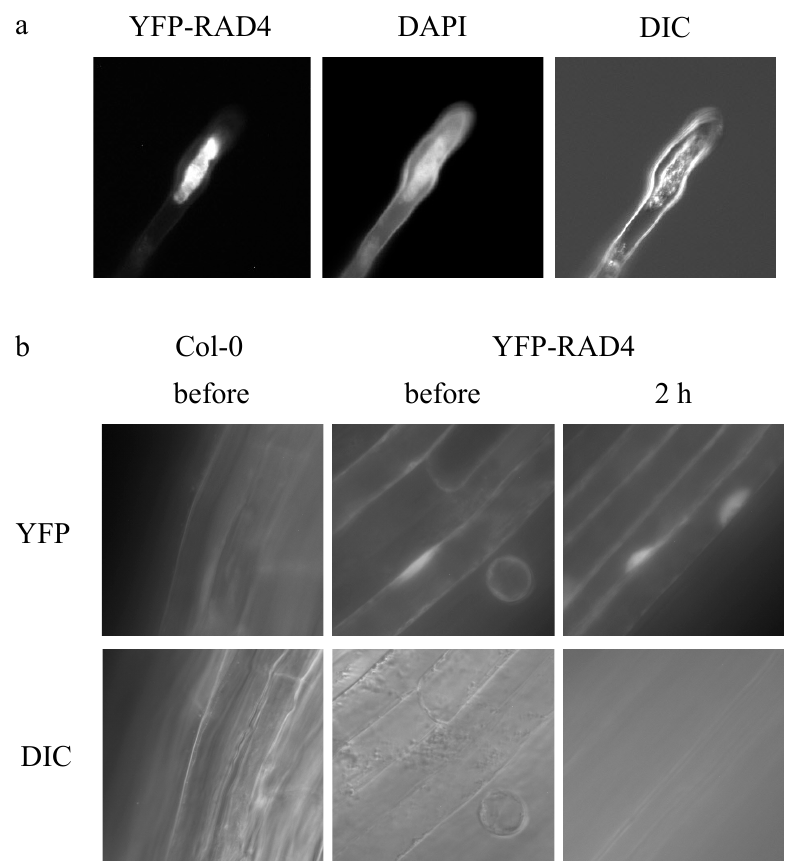
Figure 2. YFP-RAD4 exhibits nuclear localization. ( a ) Root hair cells in three-day-old 35S:YFP-RAD4 dark-grown seedlings were examined under 40× magnification using YFP fluorescence, DAPI staining, and differential interference contrast (DIC). ( b ) YFP-RAD4 in three-day-old hypocotyl cells observed under a YFP filter (top) and DIC (bottom), before and after UV treatment, under 40× magnification.